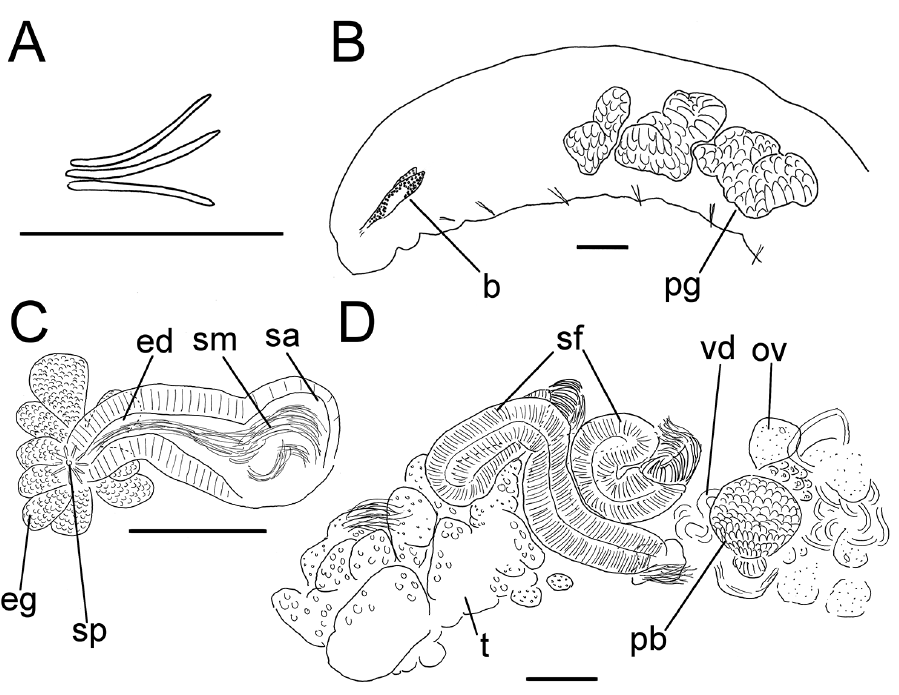
Figure 21. Lumbricillus arenarius . A Chaetal bundle B Anterior body C Spermatheca D Other genitalia. Abbreviations under general notes. Scale bars: 100